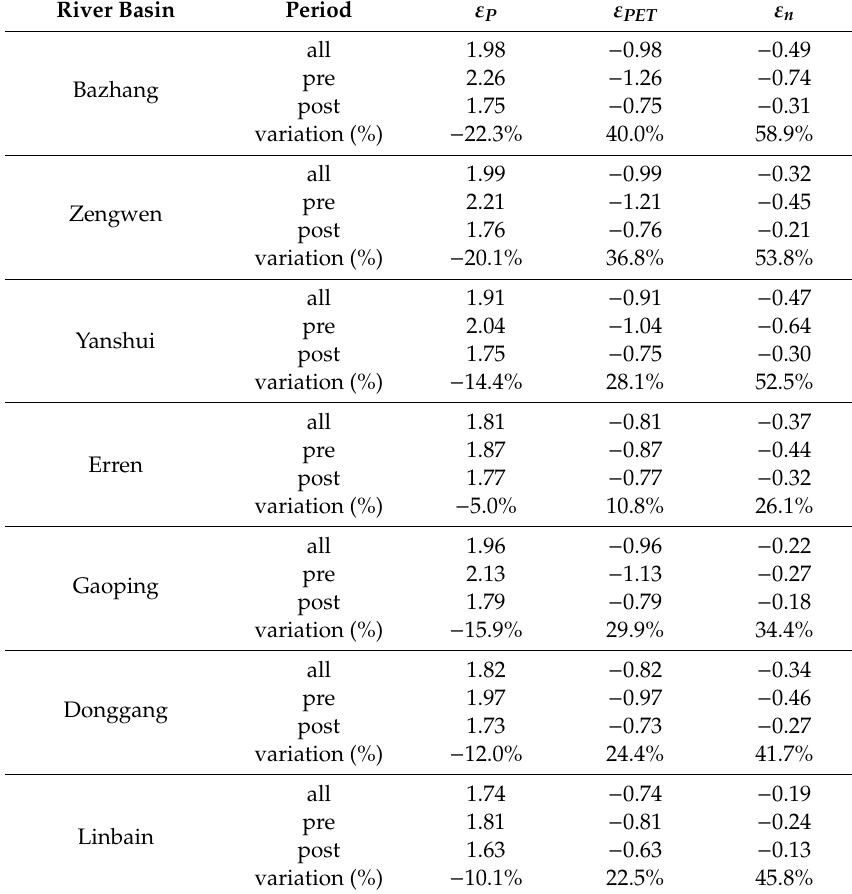
Table 6. Elasticity coe ffi cients of three hydrological variables for di ff erent periods in each river basin. River Basin Period ε P ε PET ε n Bazhang